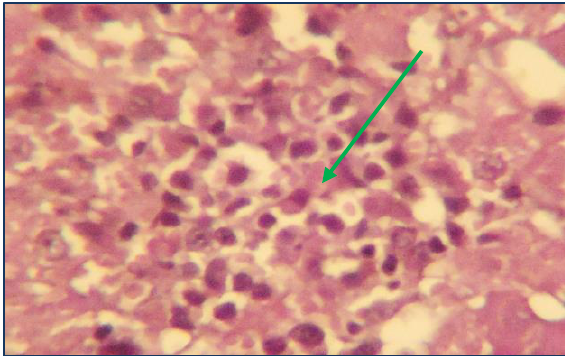
Fig, 7: Histopathological section in liver of cat showing granulomatous lesion consisting from aggregation macrophages and lymphocytes and zoites in sinusoids (H&E stain